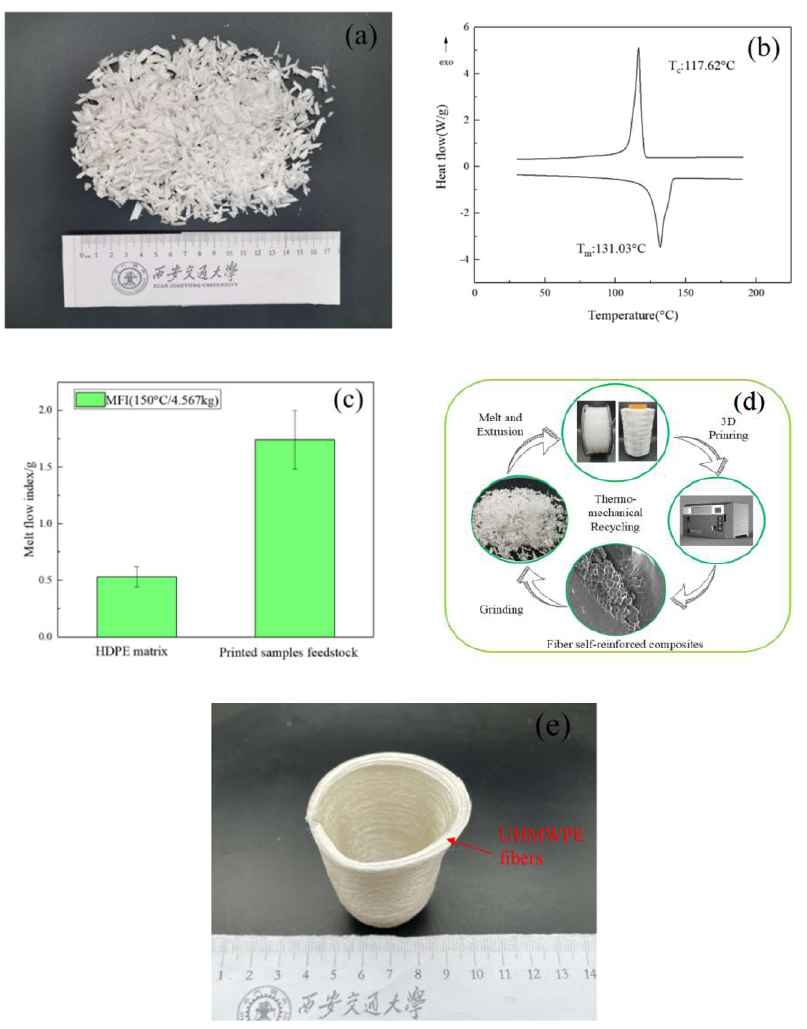
Figure 13. ( a ) Recycled printed samples as feedstock material. ( b ) DSC curves of recycled material. ( c ) MFI of HDPE and recycled material. ( d ) Closed-loop recycling. ( e ) Medical below-knee prosthetics model printed with UHMWPE fibers and HDPE matrix.